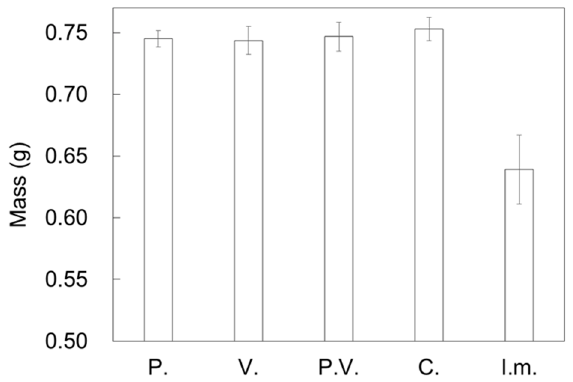
Figure 11. Comparison of the masses of the respective test pieces. Average ± S.D., n = 25.